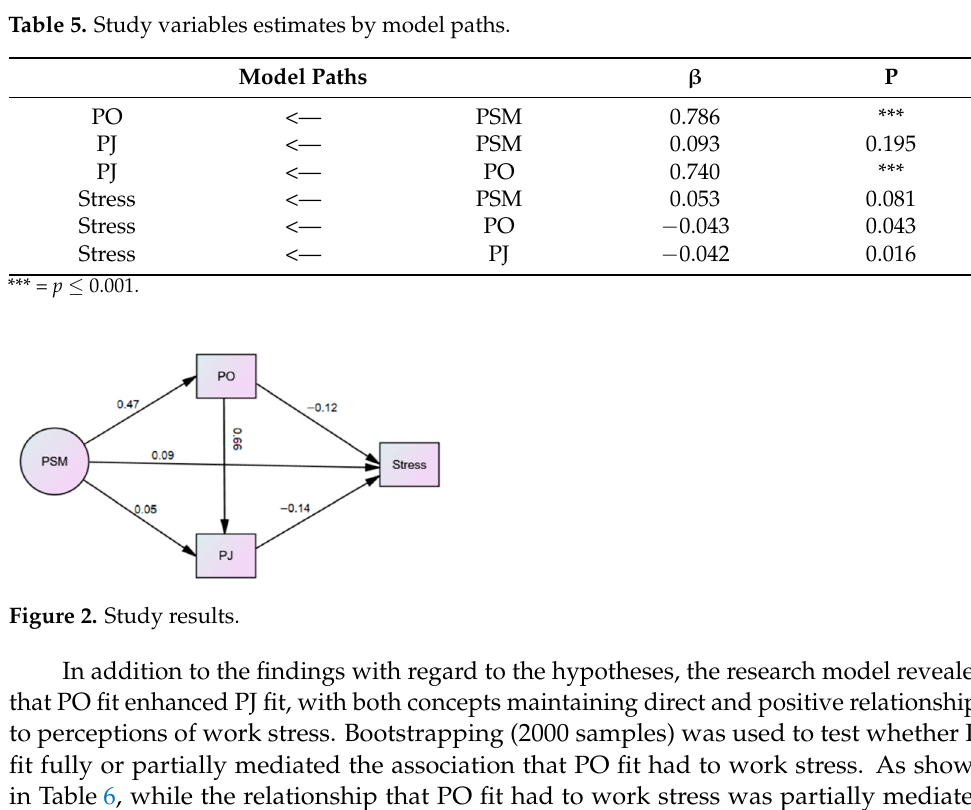
Table 5. Study variables estimates by model paths.